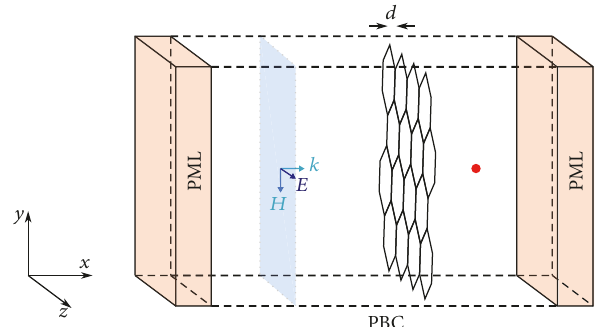
Figure 3: The TFSF plane (blue) excites a plane wave with nonzero components 𝐻 𝑦 and 𝐸 𝑧 which normally impinges upon a thin graphene sheet (hexagons) of thickness 𝑑 = 1 nm. The electric field 𝐸 𝑧 is recorded a few cells behind the graphene sheet (red) . Infiniteness in the 𝑦 - and 𝑧 -dimension is mimicked by PBCs along four of the exterior faces. The remaining two faces are covered by PMLs to absorb outgoing waves in the 𝑥 -dimension.